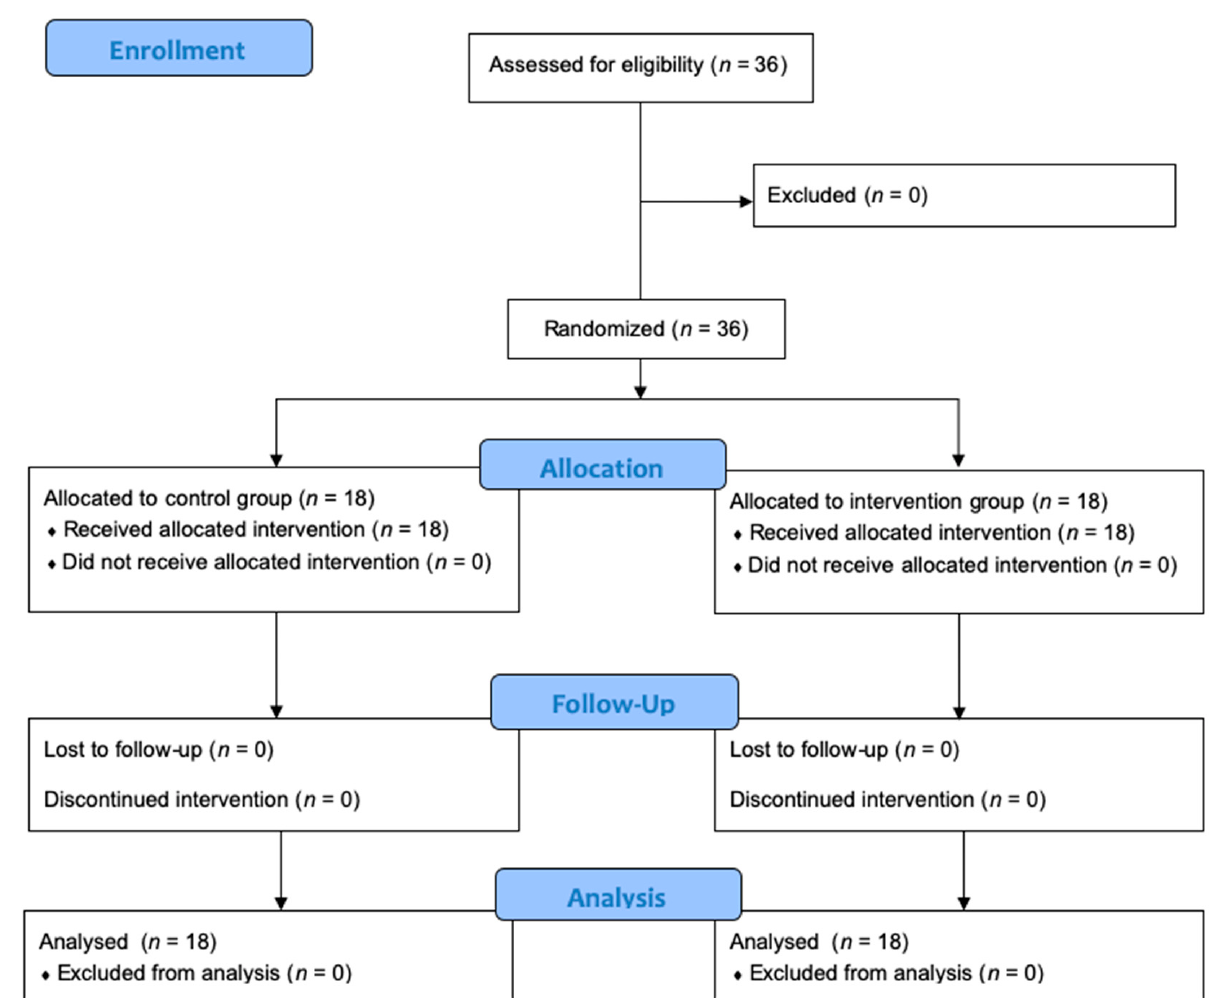
Figure 1. CONSORT flow diagram of the study.